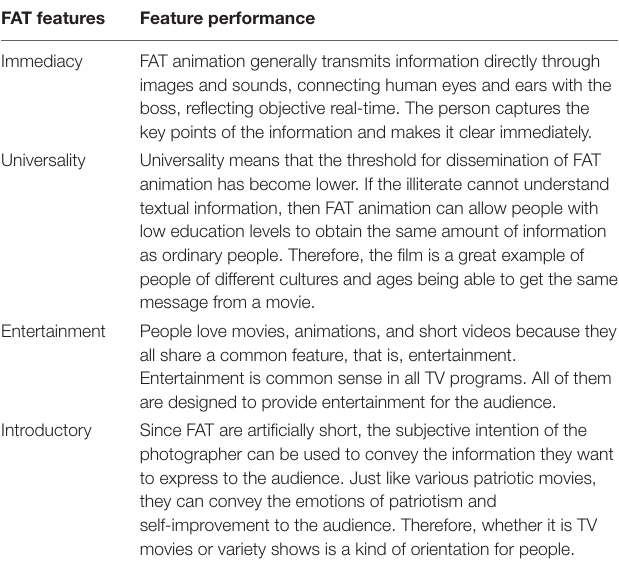
TABLE 2 | Characteristics of FAT